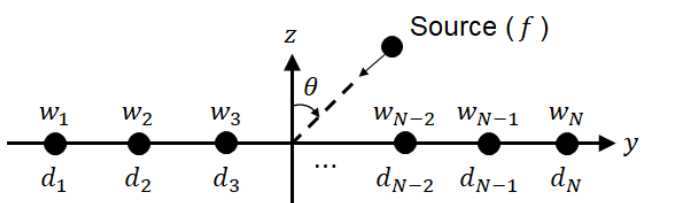
Figure 1. Geometry of asymmetric non-uniformly spaced linear array.